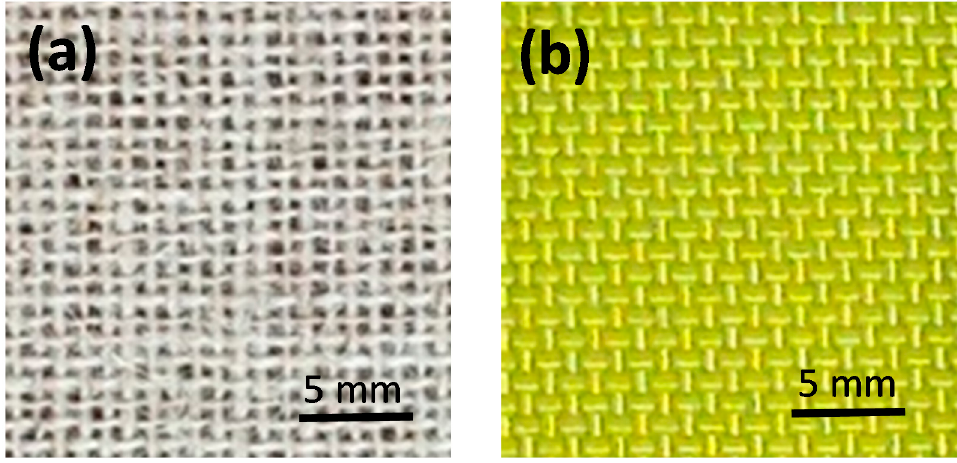
Figure 3. Plain woven fabrics of ( a ) jute and ( b ) aramid in Kevlar™.